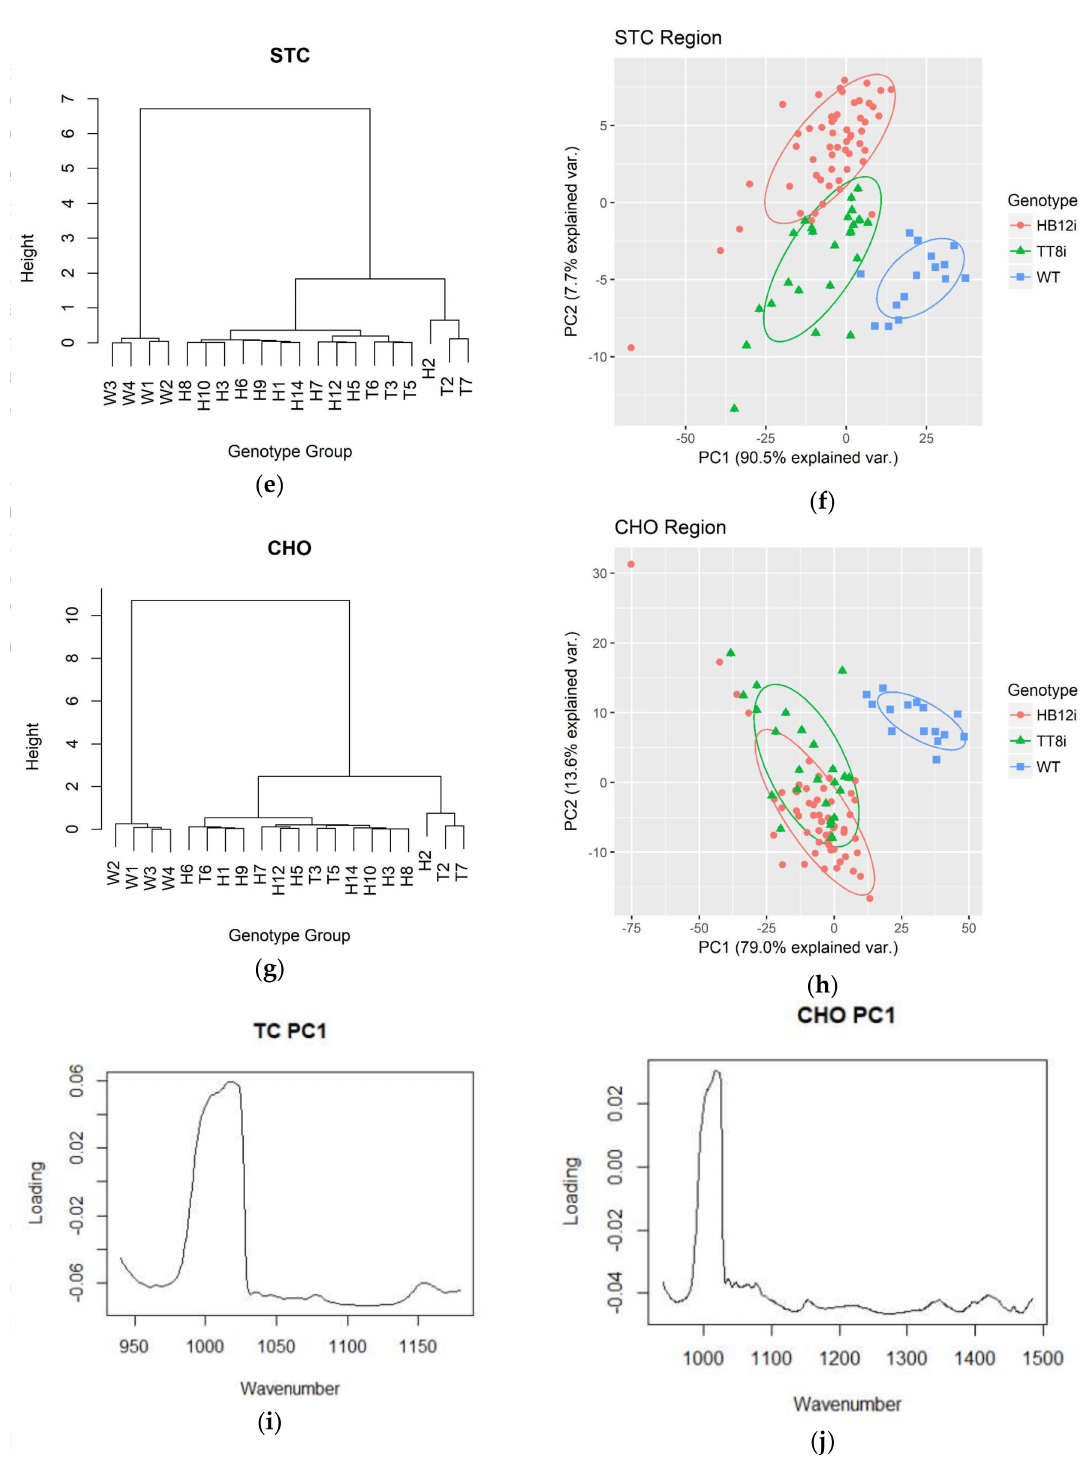
Figure 1. Hierarchy cluster analysis (HCA) dendrograms and principle component analysis (PCA) plots of carbohydrate regions of transgenic (H1–H3, H5–H10, H12, H14; T2–T3, T5–T7) and wild type (WT, W1–W4) control. TC, total carbohydrate (ca. 1178–941 cm − 1 ); CEC, cellulosic compounds (ca. 1283–1178 cm − 1 ); STC, structural carbohydrate (baseline ca. 1484–1178 cm − 1 ); CHO, whole carbohydrate region (ca. 1484–941 cm − 1 ). ( a ) HCA dendrogram of TC; ( b ) PCA plot of TC; ( c ) HCA dendrogram of CEC; ( d ) PCA plot of CEC; ( e ) HCA dendrogram of STC; ( f ) PCA plot of STC; ( g ) HCA dendrogram of CHO; ( h ) PCA plot of CHO; ( i ) PC1 loading of TC against wavenumber; ( j ) PC1 loading of CHO against